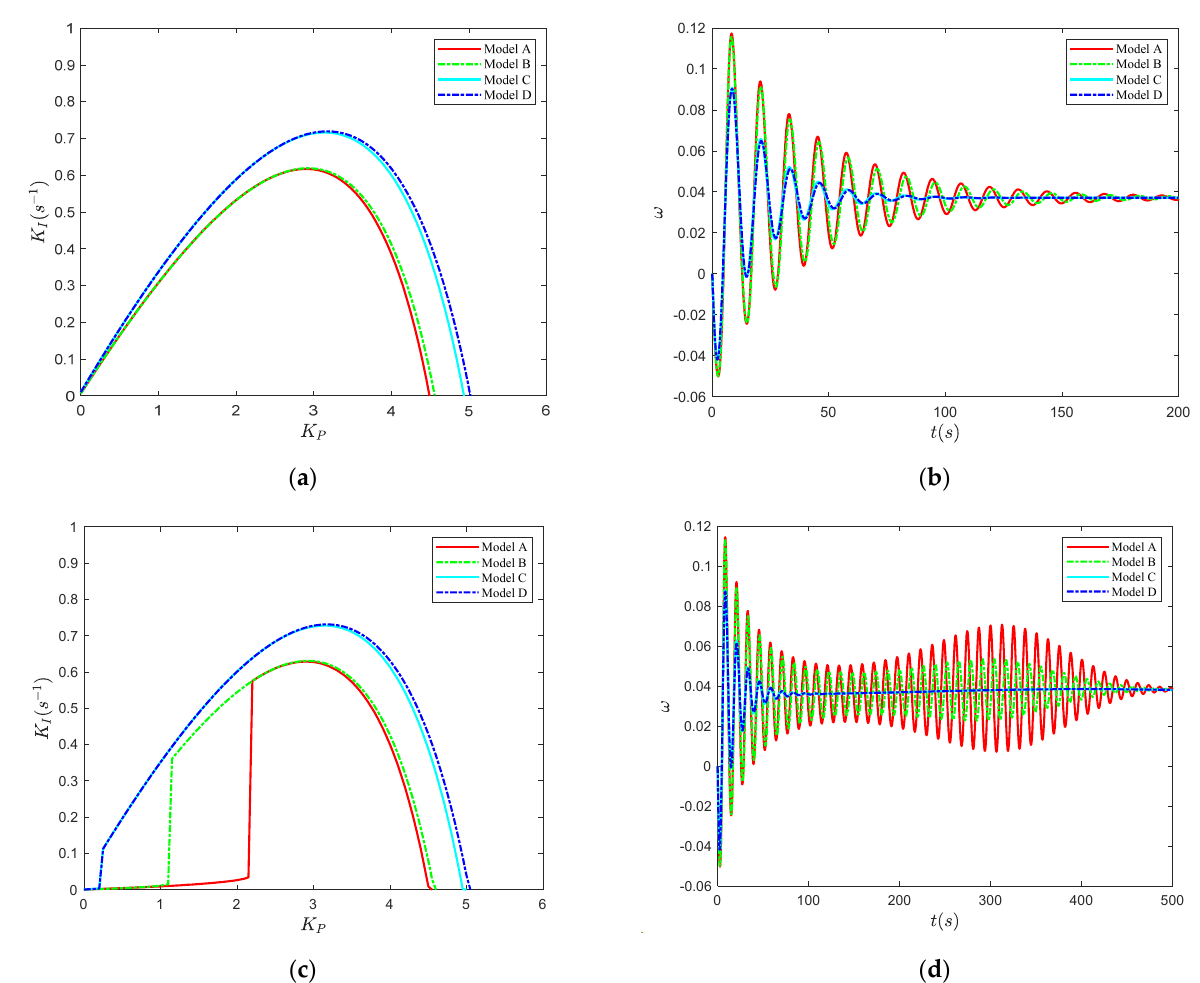
Figure 8. Stable region and dynamic responses of DFVSPSPS under p = 0.10: ( a ) T F = 1500 s; ( b ) T F = 1500 s; ( c ) T F = 250 s; ( d ) T F = 250 s.